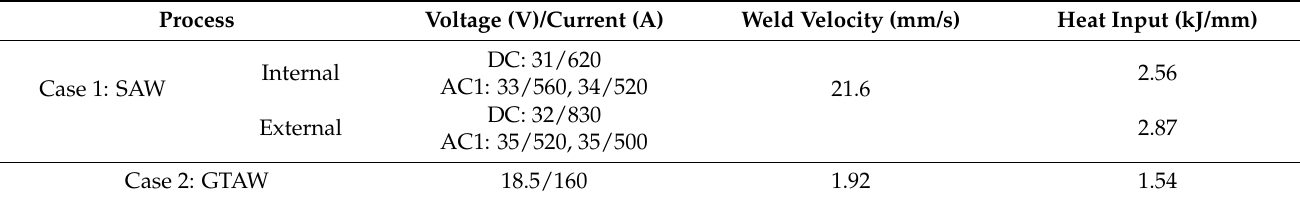
Table 3. Conditions of welding process for SAW and